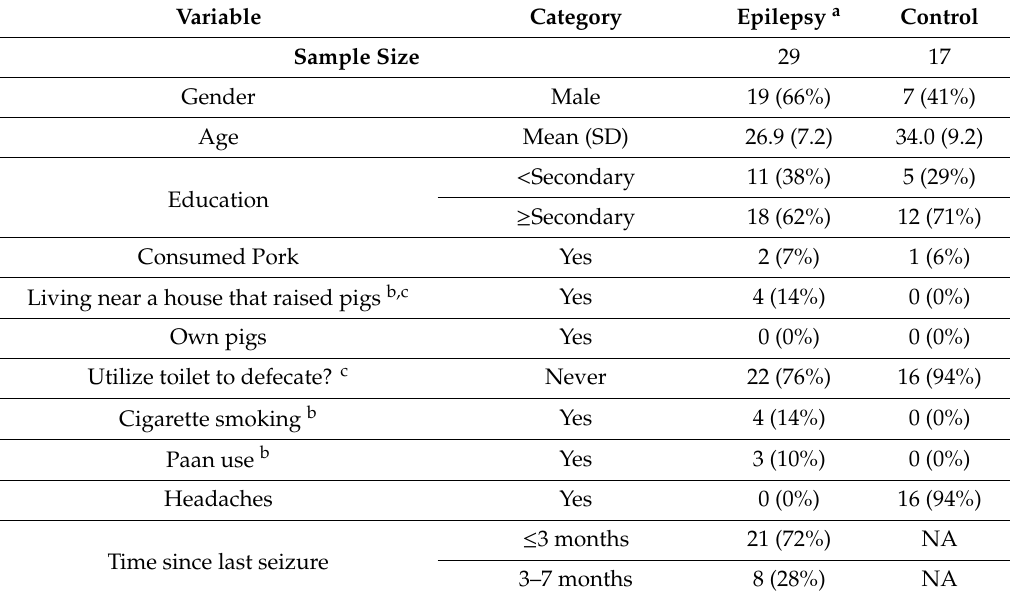
Table 1. Sociologic, demographic and clinical characteristics of participating patients with epilepsy a and control